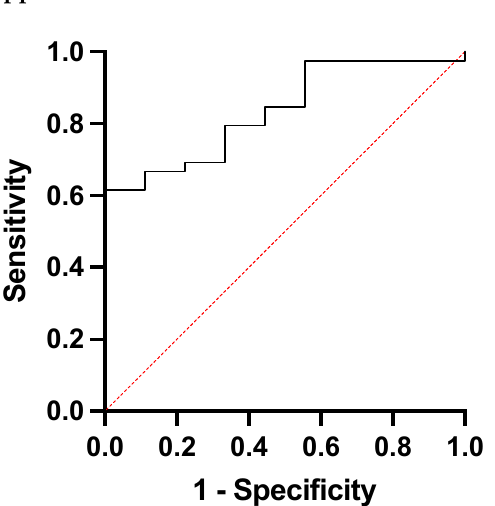
Figure A1. The ROC curve for differentiating ERMCs via PLA in NASH and NAFL. Table A1. The diagnosing performance of Figure A1 of PLA assay for NASH from NAFL. Area under the ROC